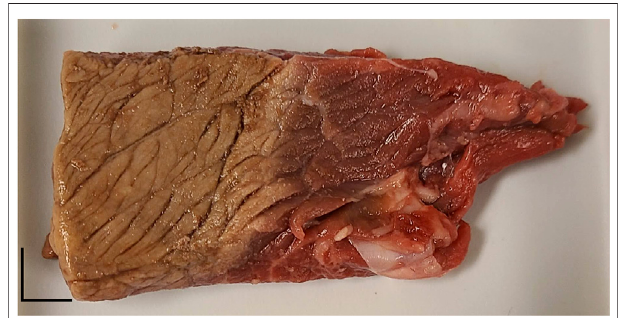
FIGURE 2 | Photograph of the steak sample. The left side was cooked and the right side was uncooked. The boundary can be clearly seen in the middle. The scale bar is approximately 1 cm in each